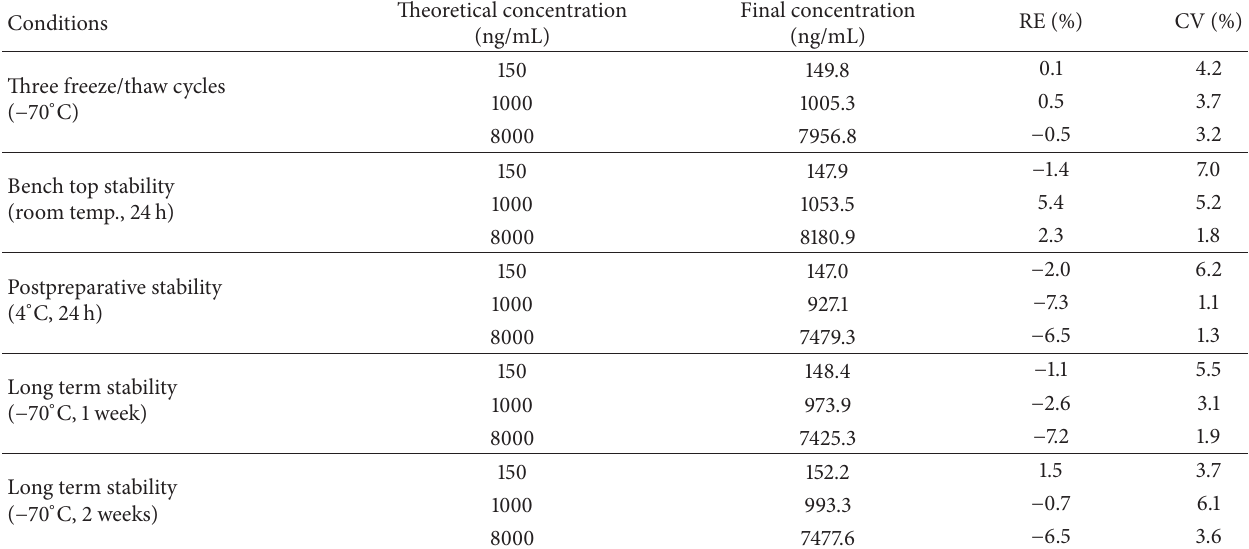
Table 4: Stability of PD in rat plasma ( 𝑛 = 5 at each level).